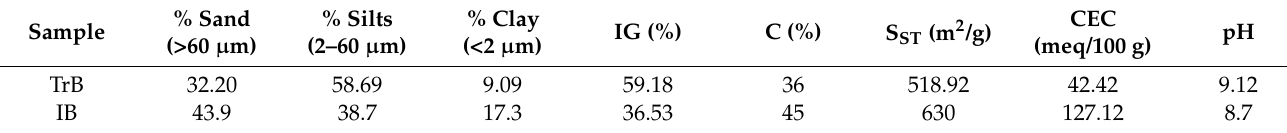
Table 1. Physicochemical properties of bentonite samples used in the